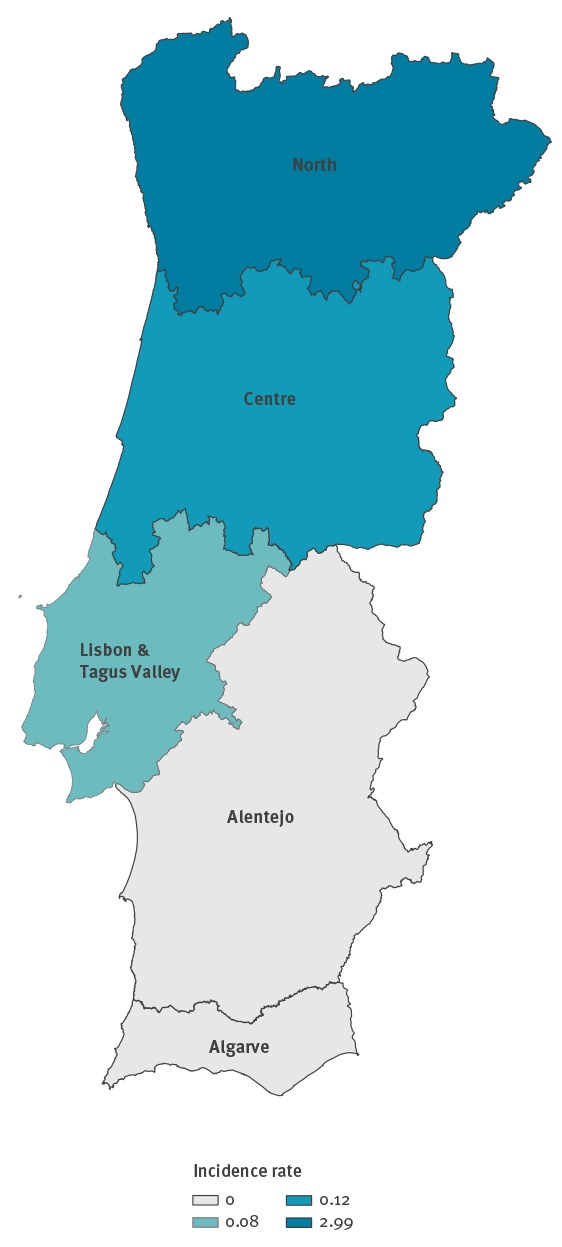
Incidence rate of confirmed measles cases per 100,000 population by health region, Portugal, 11 February−28 April 2018 (n = 112)